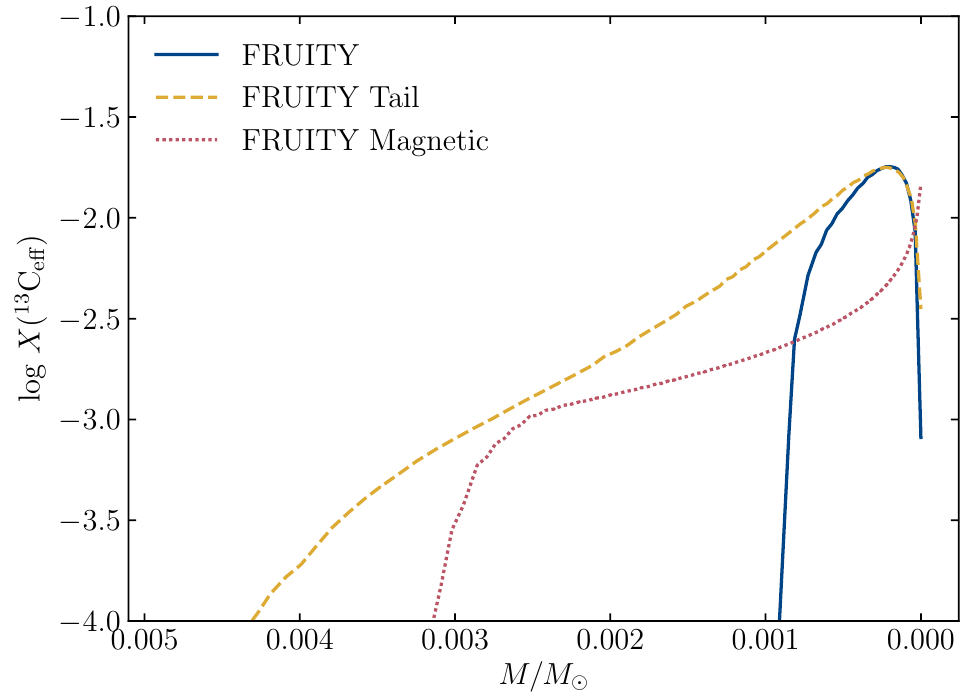
Figure 2. Effective 13 C in the 13 C pocket region for models with different physical prescriptions. The mass fraction of effective 13 C is defined as X ( 13 C eff ) = X ( 13 C ) the most efficient neutron poison, the X ( 13 C eff ) quantifies the number of neutrons that will be released at following activation of the 13 C( α , n) 16 O reaction and therefore is a good estimator of the s-element